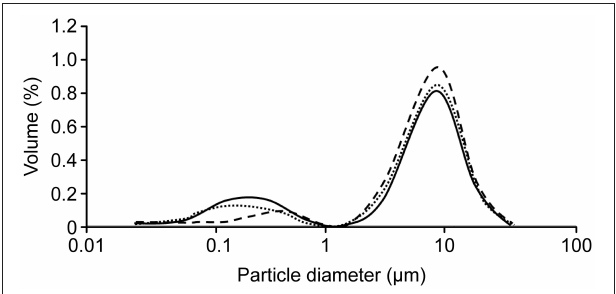
FIGURE 2 | Distribution of the volume size of milk fat globules (MFGs): raw ( ____ ) pasteurized (- - - - ) or high pressure ( ……… ). Evaluation of the size of MFGs showed that the population was bimodal he proportion of “small MFGs” was greater in raw milk and HHP-treated milk (d3.2 = 0.6 vs. 0.8 µ m, respectively) compared to that in LTLT-pasteurized human milk (d3.2 = 3.1 µ m). This result suggests that the size structure of raw breast milk is preserved by HHP treatment, whereas LTLT promotes coalescence and therefore increases the number of “large” MFGs.